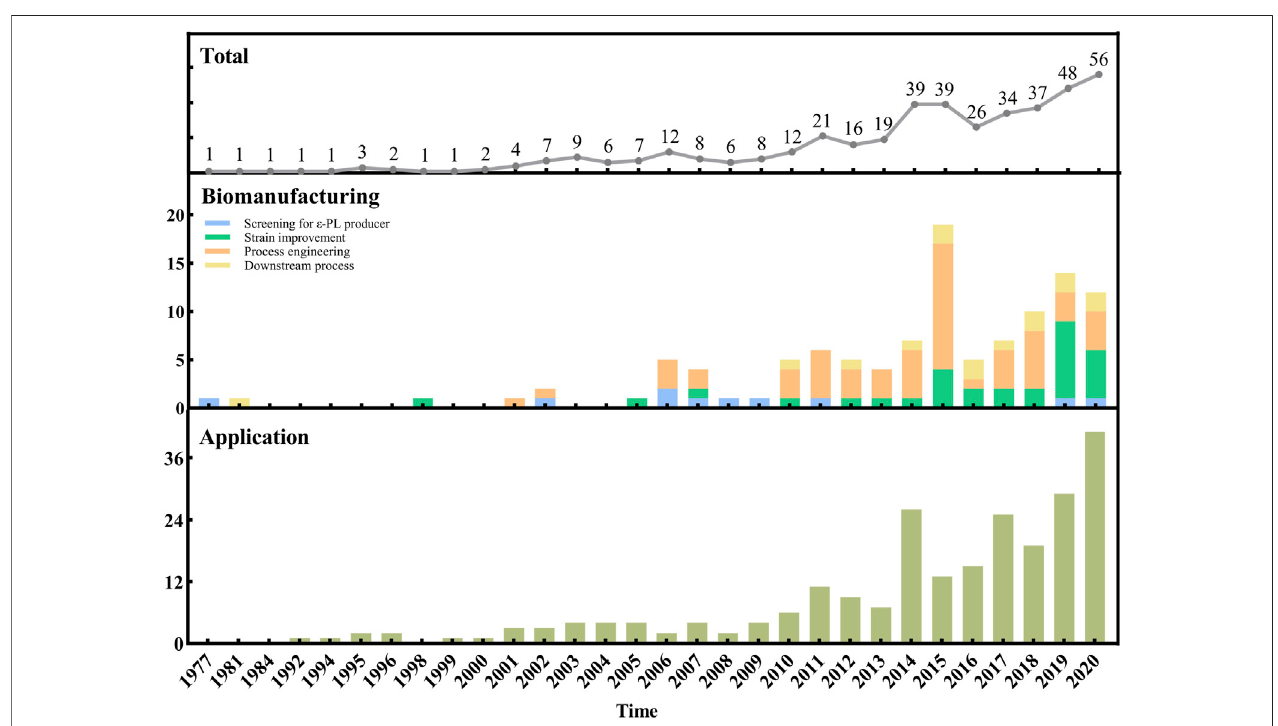
FIGURE 1 | Evolution over the years of the number of references concerning the biomanufacturing and applications of ε -PL.